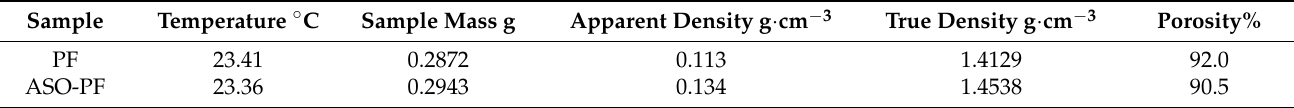
Figure 2. ( a ) N 2 adsorption-desorption isothermal curves of ASO-PF and ( b ) pore size distribution curves of PF and ASO-PF. Table 1. Apparent/true density and porosity of PF and ASO-PF.